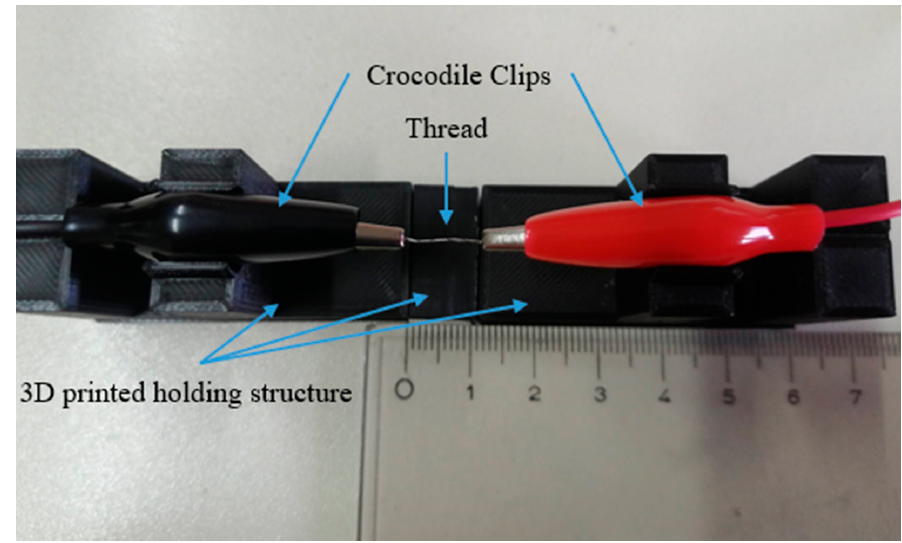
Figure 2. The custom-built experiment holding structure, with a thread sample attached.